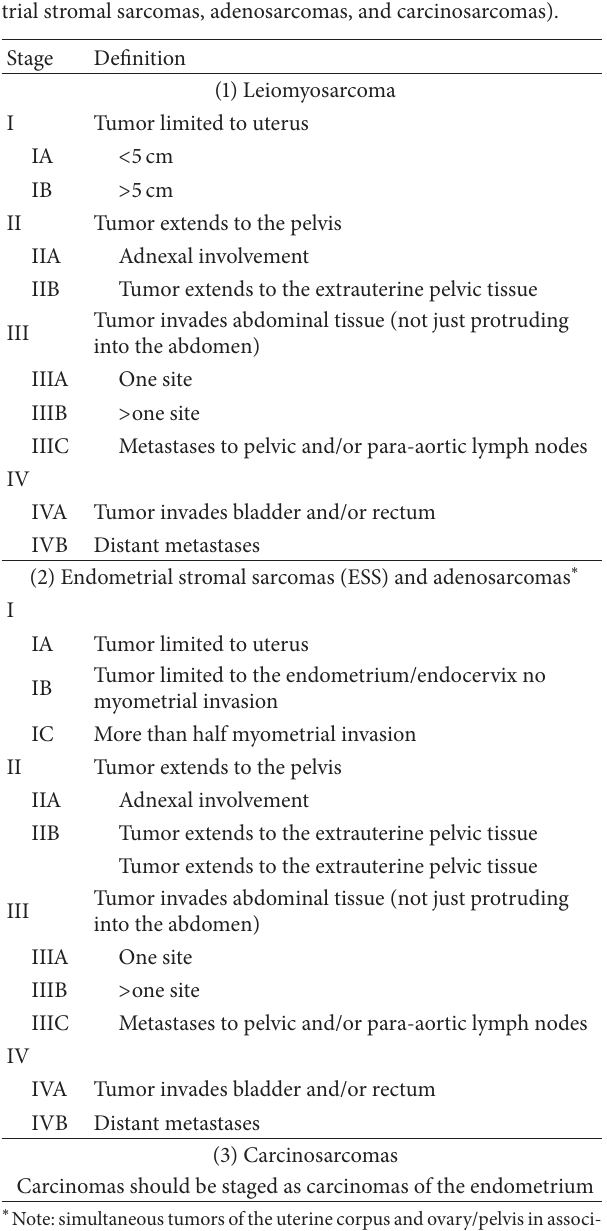
Table 1: Staging for uterine sarcoma (leiomyosarcomas,